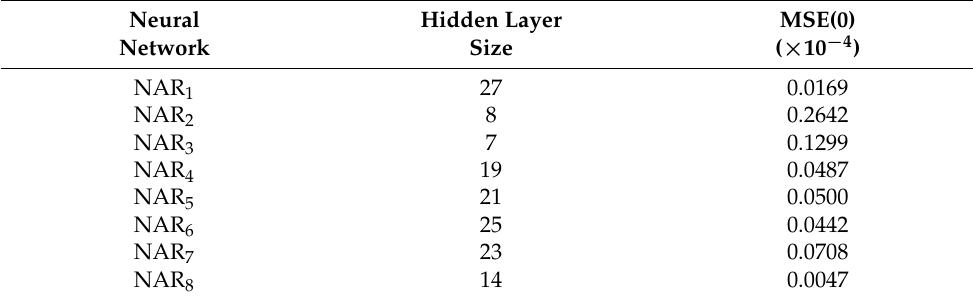
Table 3. Hidden layer size of networks for the second